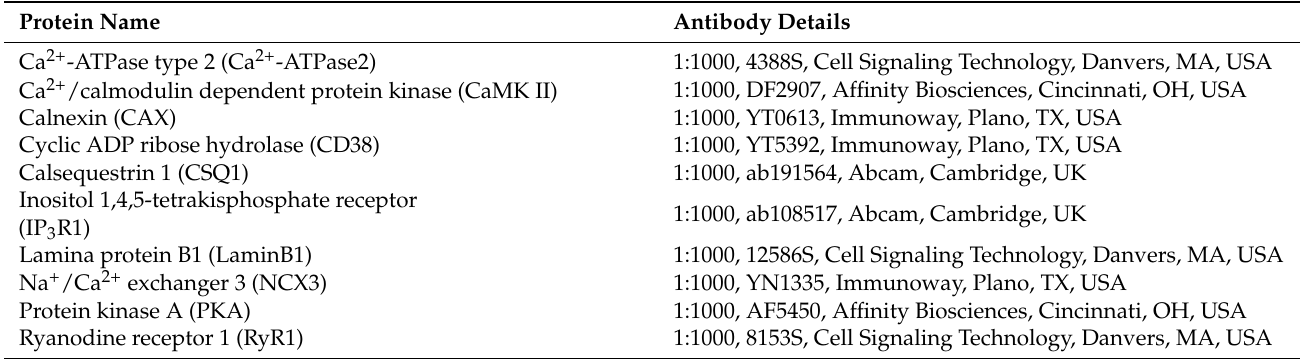
Table 1. Primary antibodies used in Western blot